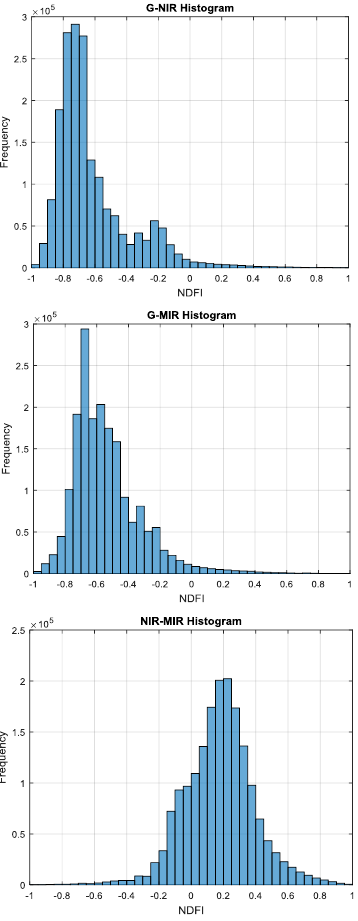
Figure 7. NDFI histograms of Site I